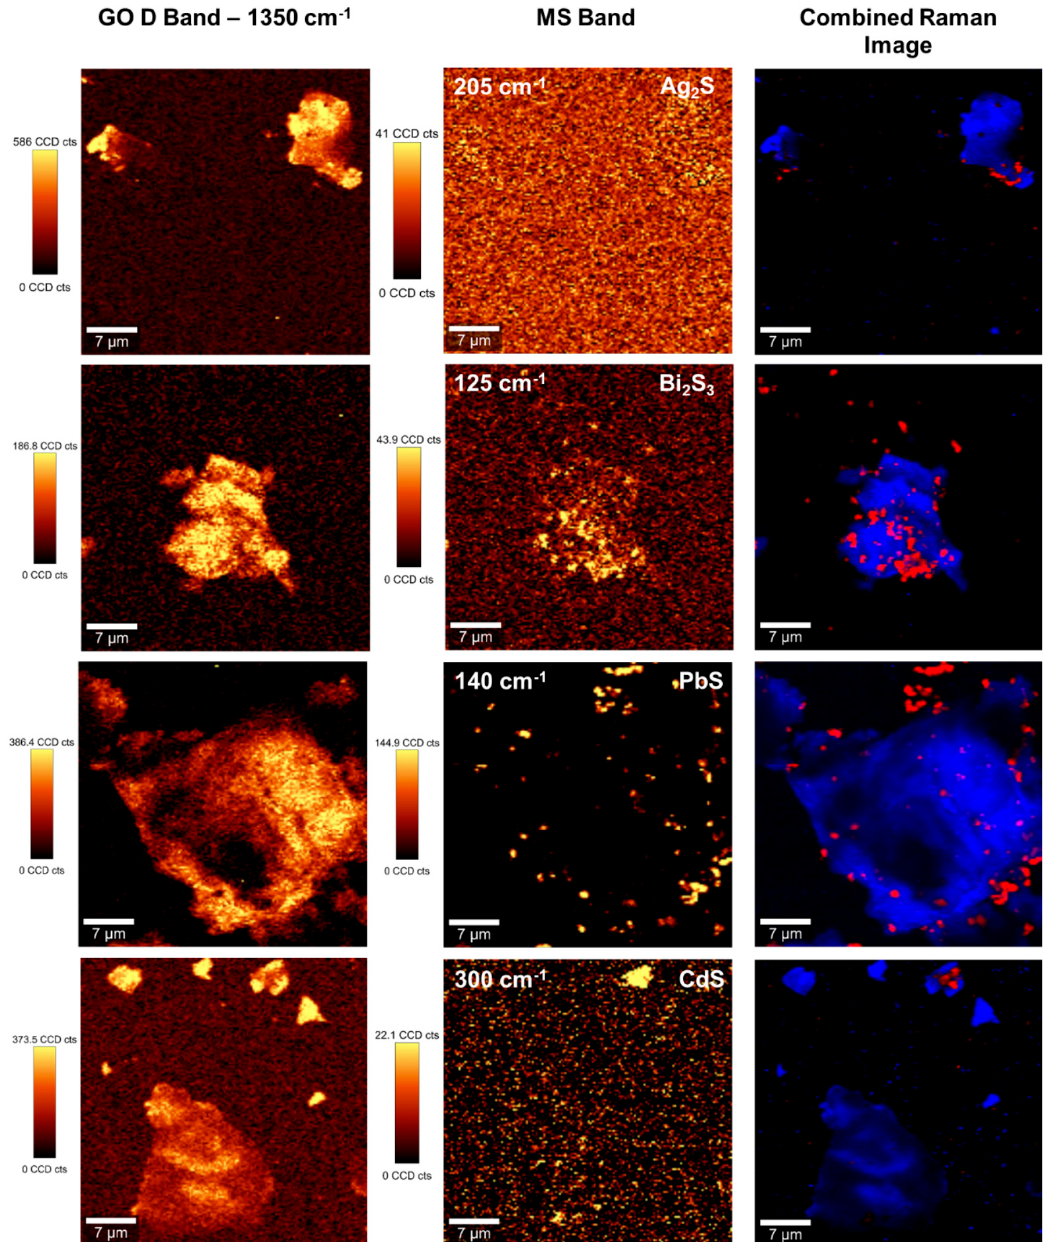
Figure 7. Raman images of GO decorated with metal sulfides (as indicated in the middle panel images). The Raman images were obtained by using the integrated intensity of the Raman band of GO at 1350 cm − 1 ( left panel) and the characteristic Raman band of the metal sulfide as indicated ( middle panel)—excitation line at 532 nm, 1 mW laser power, 150 × 150 points per grid in a 40 × 40 µ m area. The vertical bar shows the color profile in the Raman images, with the relative intensity scale. The combined Raman images of the GO substrate and metal sulfides are also shown ( right panel).